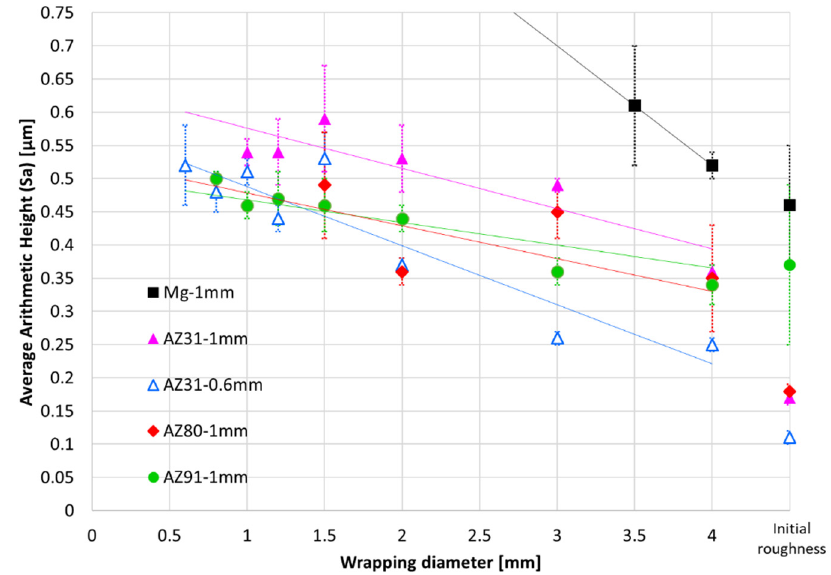
Figure 9. Averaged surface roughness (Sa) in µm vs. the wrapping diameter of the wrapped